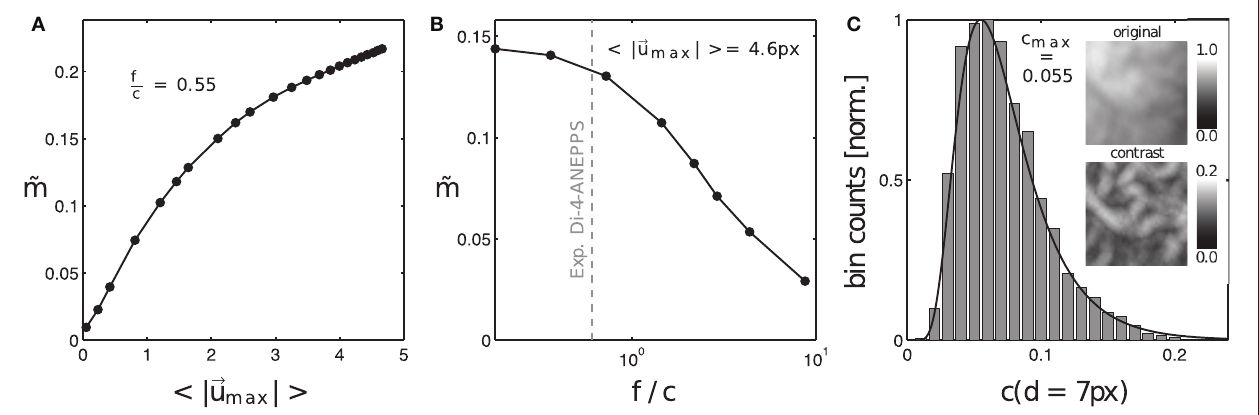
FIGURE 8 | Motion artifact strength ˜ m generated systematically in synthetic optical mapping videos, see also Figure 3 . (A) Increase in motion artifact strength ˜ m with increasing amplitudes of motion |E u | . (B) Decrease in motion artifact strength ˜ m with increasing fluorescent signal strength f or decreasing local tissue contrast c . The strength of motion artifacts depends on the relative signal-to-contrast ratio f / c . (C) Distribution of image contrast in optical mapping video frame used to generate synthetic optical mapping video. Top image: original texture, normalized to [0,1]. Bottom image: contrast image. Image contrast c is the maximal absolute intensity difference that is found around a pixel ( x , y ) within a disk-shaped region S xy with diameter d (here typically 5 − 7 pixels).